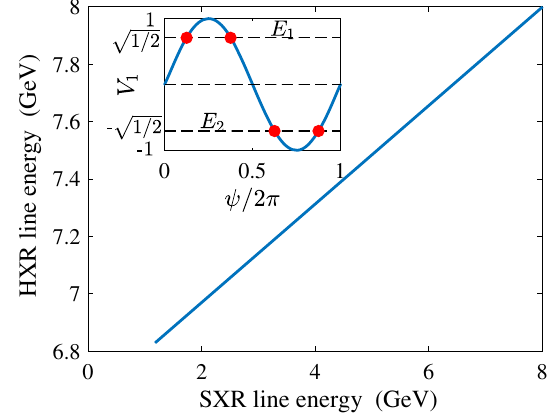
FIG. 6. Available beam energies for SXR and HXR lines when using the special solution of four-line